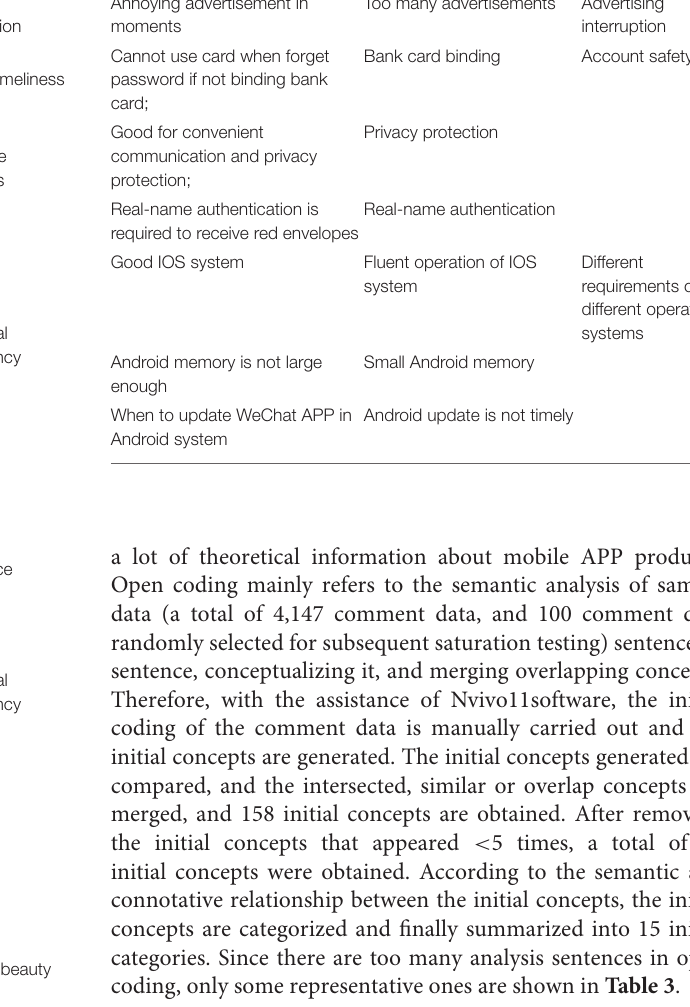
TABLE 3 | Partial open coding process. Original information (partial) Initial conceptualization Categorization Occupies too much memory and the start-up speed is slower and worse than